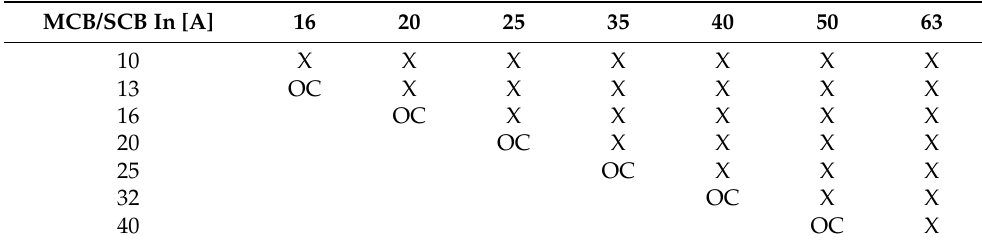
Table 2. Coordination table